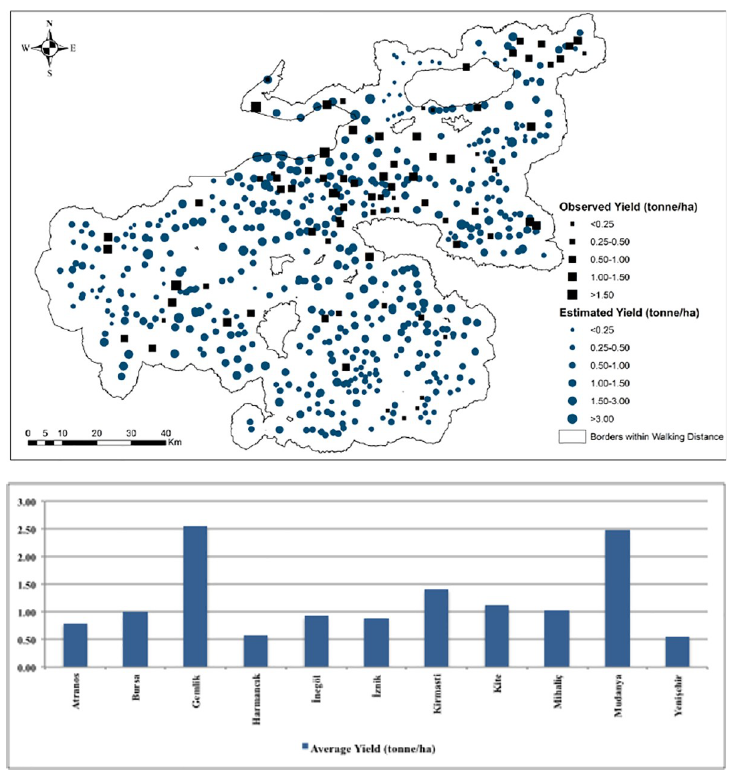
Fig 11. Distribution of average yield (tonne/ha) of predicted and observed